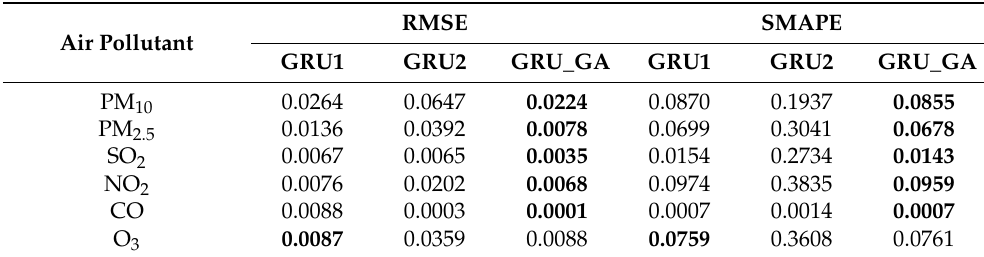
Table 10. The result of the adaptive GRU network structure compared with manually designed GRU network structures with Dataset